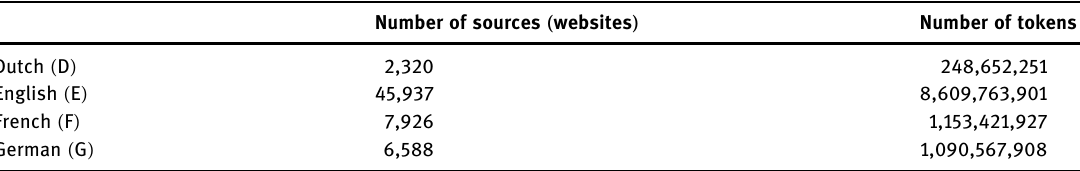
Table 1: JSI Timestamped Corpora main fi gures ( 2020 subcorpora